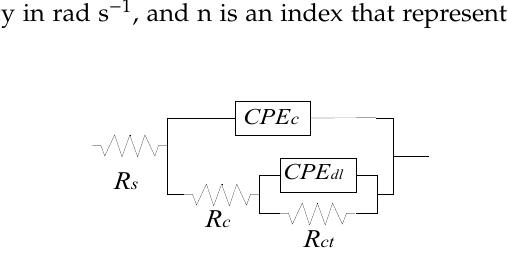
Figure 12. An equivalent electrical circuit (EEC) model.